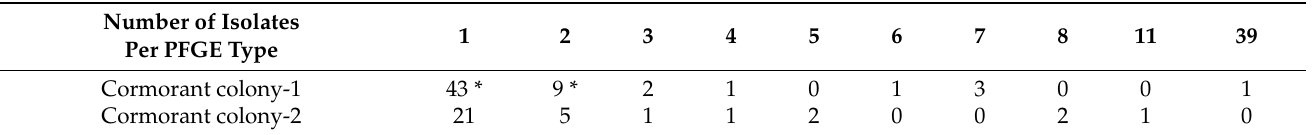
Table 1. Summary of pulsed-field gel electrophoresis (PFGE) types and number of isolates in each type in cormorant colony 1 and 2. Number of